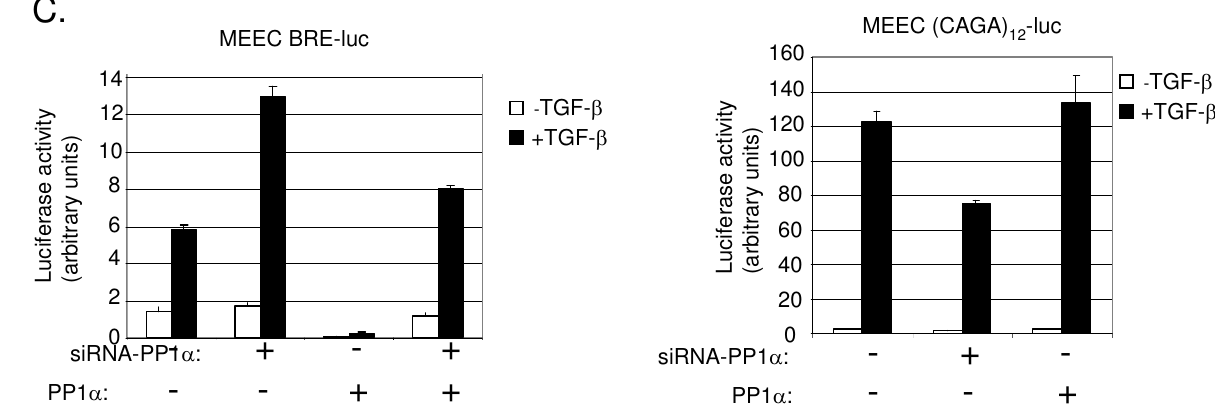
-luc in the absence or presence of PP1 α . After 12